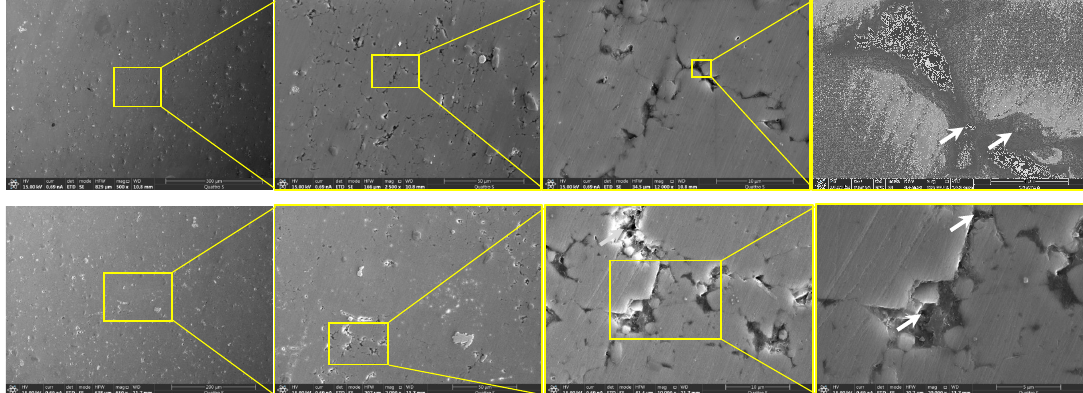
Figure 10. SEM images for samples #545-1 and #545-2 (white arrows indicate voids).